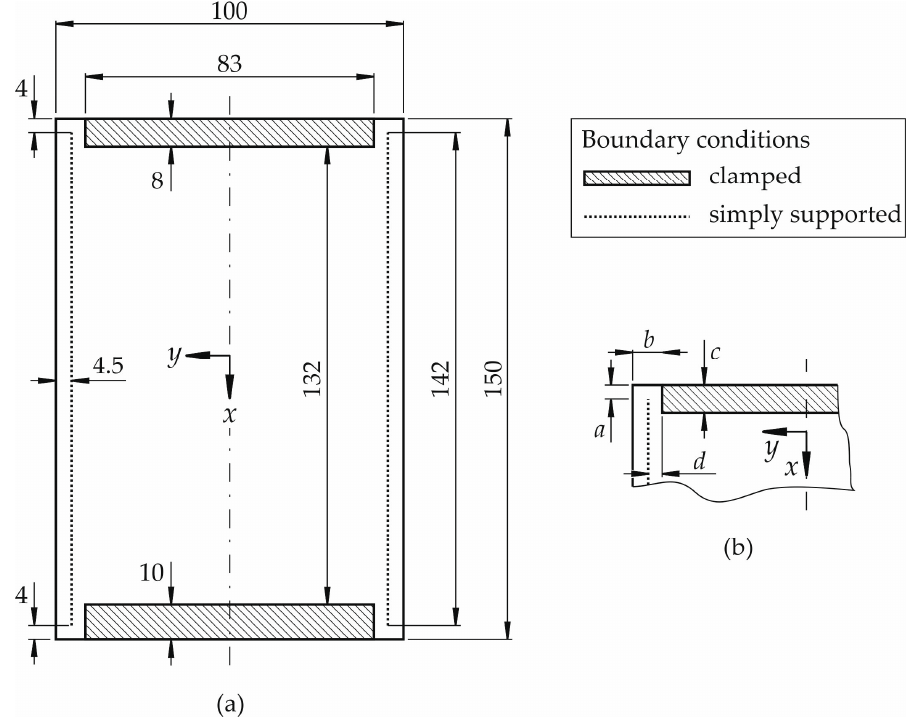
Figure 1. ( a ) Schematic fixture of composite plate (nominal dimension 100 mm × 150 mm) within typical CAI-standard test devices (cp. e.g., standards [1,5]) and ( b ) modified upper corner of CAI test device.